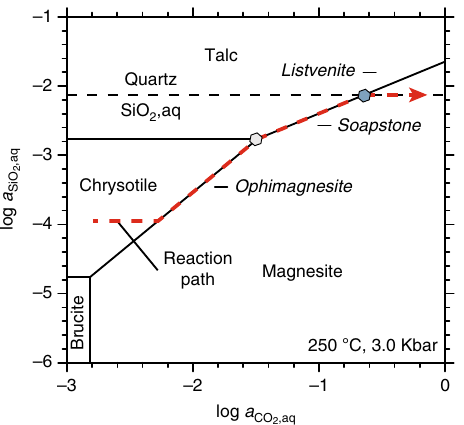
Fig. 3 Reaction path of serpentinite carbonation. CO 2 – SiO 2 activity diagram in the system MgO – SiO 2 – H 2 O – CO 2 showing the reaction path of progressive serpentinite carbonation resulting in ophimagnesite (serpentine + magnesite), soapstone (talc + magnesite), and listvenite (quartz + magnesite) formation at constant pressure and temperature. Hexagon symbols mark CO 2 activity values used in Fig. 9. Mineral stability fi elds are calculated using the computer program Supcrt and thermodynamic database dprons96.dat 50 , quartz saturation is based on the thermodynamic data of Rimstidt 51 . The estimated pressure of 3 kbar is based on a normal thermobaric gradient in a slightly thickened crust (12 bar/°C) 52 . The same diagram calculated for alteration temperatures of 180 °C and 300 °C is included in the supplement (Supplementary Fig.